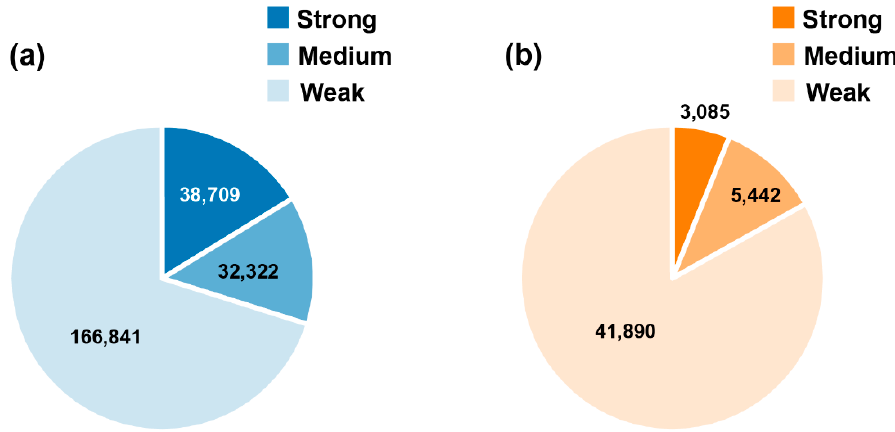
Figure 2. The druggability distribution of AlphaFold cavities ( a ) and hrefPDB cavities ( b ). As previously mentioned, about 37% of human proteins have corresponding PDB entries, so we split all the AlphaFold cavities into two subsets: one subset contains all cavities from proteins that have known 3D structures in our hrefPDB dataset (Subset_1), and the other subset contains the remaining cavities (Subset_2). Figure 3 shows the Index distributions of these two subsets. The median Index of Subset_1 is higher than that of Subset_2, implying that AlphaFold gives more accurate structure predictions for proteins with known 3D structures. However, for cavities with strong druggability, the Index val- ues significantly decreased, indicating that the AlphaFold predicted protein structures may contain false-positive druggable pockets. Therefore, we include the Index scores for each cavity in our library to help users pick reliable druggable pockets. Figure 3. The distributions of Index that is the proportion of cavity residues with high confidence (pLDDT > 90). AF_cavity: cavities detected from AlphaFold predicted protein structures; Subset_1: cavities from proteins that have known 3D structures in our hrefPDB dataset; Subset_2: the remain- ing cavities after removing Subset_1 from AF_cavity. The distributions of all cavities (blue) and cavities with strong druggability (orange) in each dataset are displayed respectively. 3.2. The Quality of Cavity Detection over AlphaFold Structures